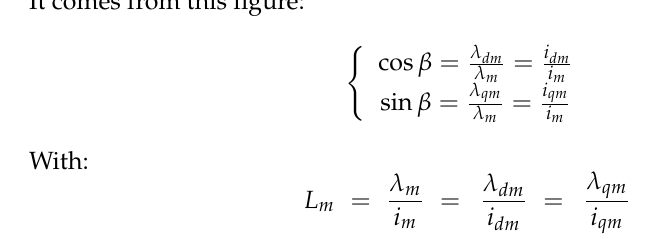
Figure 6. Current position and magnetizing flux in the frame (d–q).